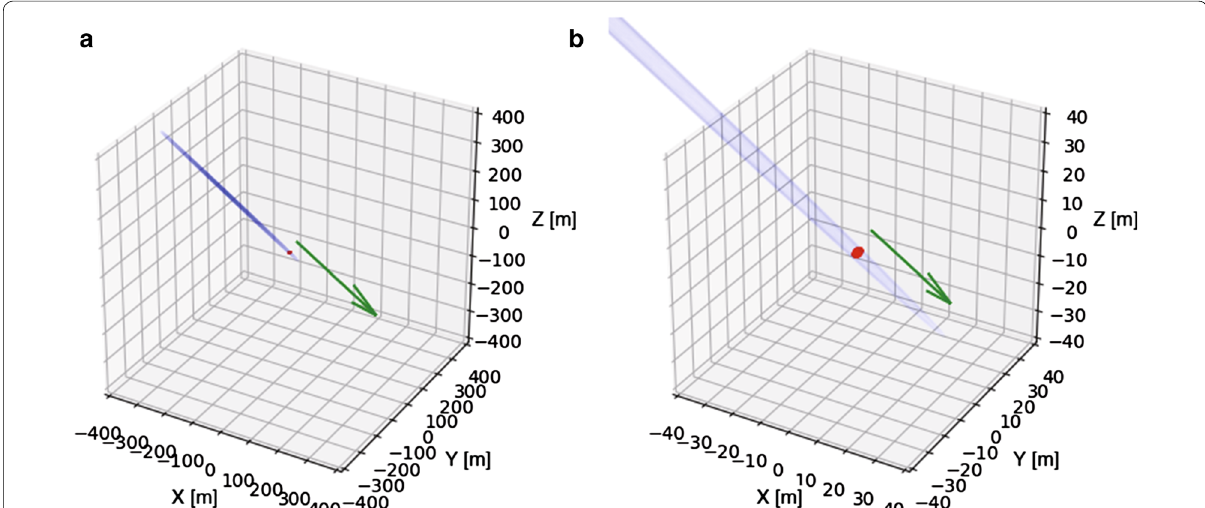
Fig. 5 Error ellipsoids derived from solution covariance matrices. a The cases of orbit determinations of arc No. 3 in Table 1 using centroid direction and number of bright pixels of AIT data (blue) and using both centroid direction of AIT data and LIDAR range data (red). Green arrow indicates the direction of the center of Ryugu. b Enlarged view of